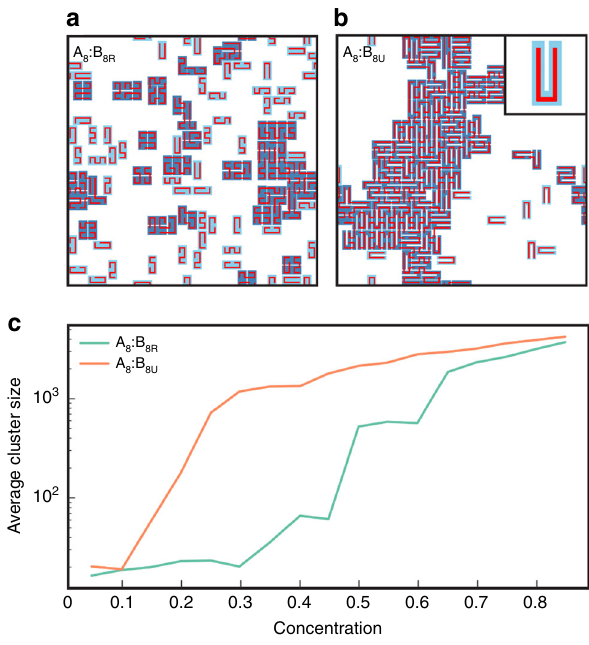
Fig. 2 Lower conformational entropy of dimers favors clustering. Snapshots of simulations of a A 8 : B 8 rigid 4 ´ 2 rectangles that restrict a dimerizing polymer partner to adopt a speci fi c U-shape (see Methods). Parameters: speci fi c bond energy = 10 k non-speci fi c bond energy = 0.1 k concentration = 0.4. Inset in b shows a fully-bonded U-shaped dimer. c Average cluster size versus monomer concentration for systems in a , b